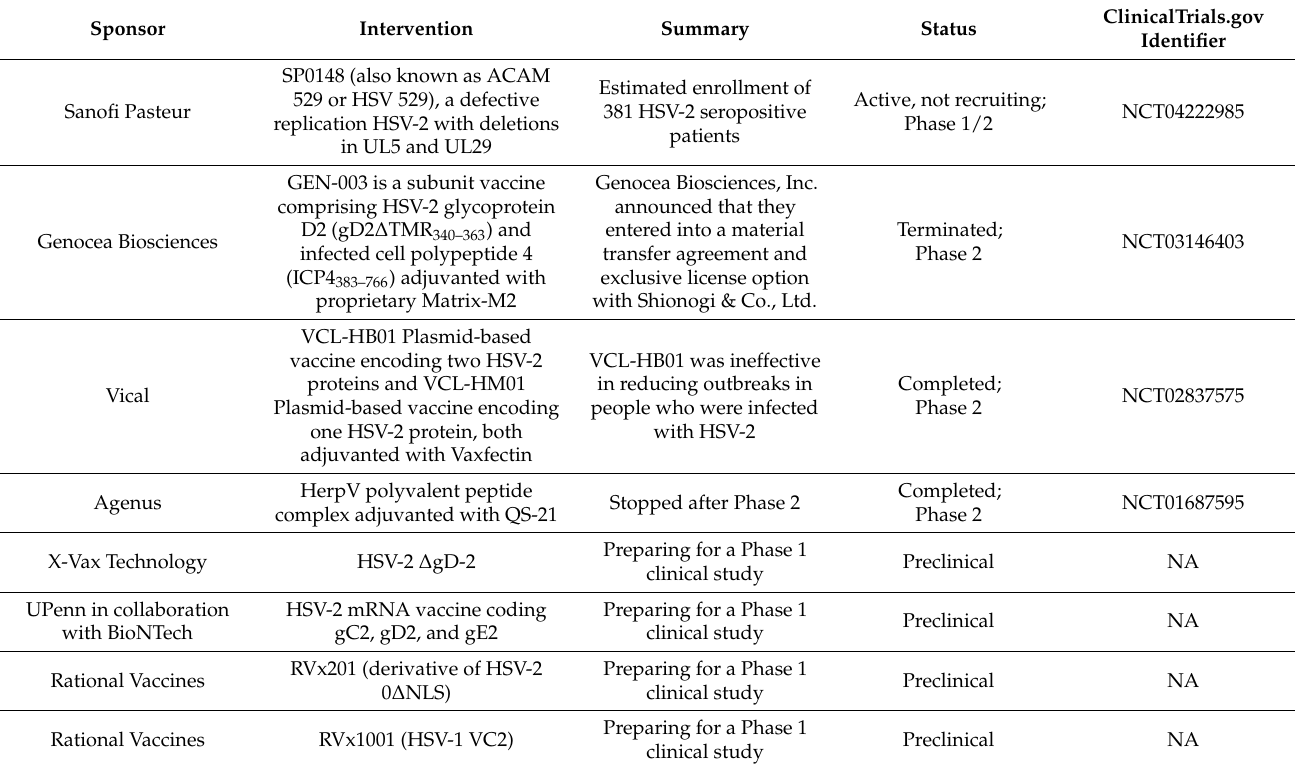
Table 2. Recent/current/pending clinical trials of herpes simplex